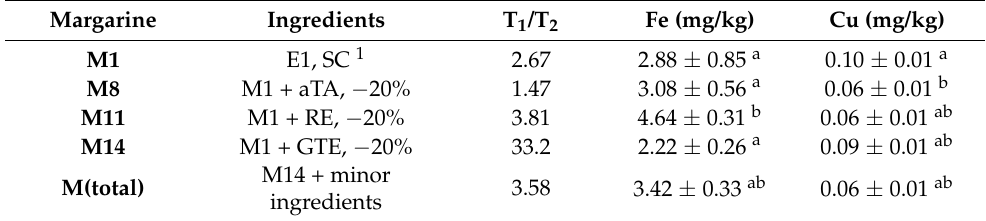
Table 3. Determination of T 1 / T 2 , Fe (mg/kg) and Cu (mg/kg) measured by NMR, TXRF and GFAAS, respectively, in selected margarine samples. NMR data are depicted as single measurements. TXRF and GFAAS data are depicted as mean ± SD (n = 3). Statistically significant differences between the margarine samples regarding their Fe and Cu content are indicated with different lowercase letters a and b (one-way ANOVA, Holm–Sidak, p <